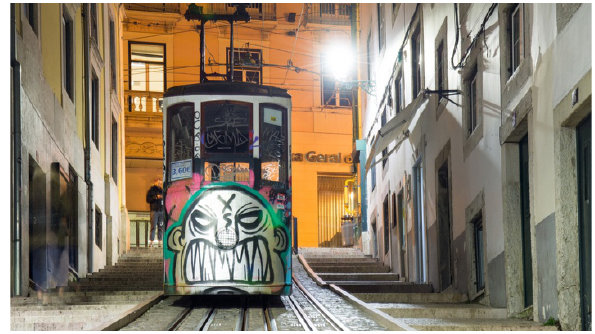
Figure 8. Photograph extracted using the keyword “Graffiti” in the city of Lisbon (Flickr,